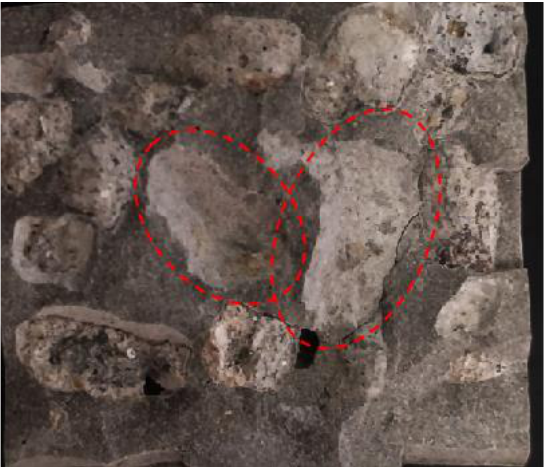
Figure 4. XRD interface sampling area. (red circle indicates the debonding area of the aggregate and mortar).